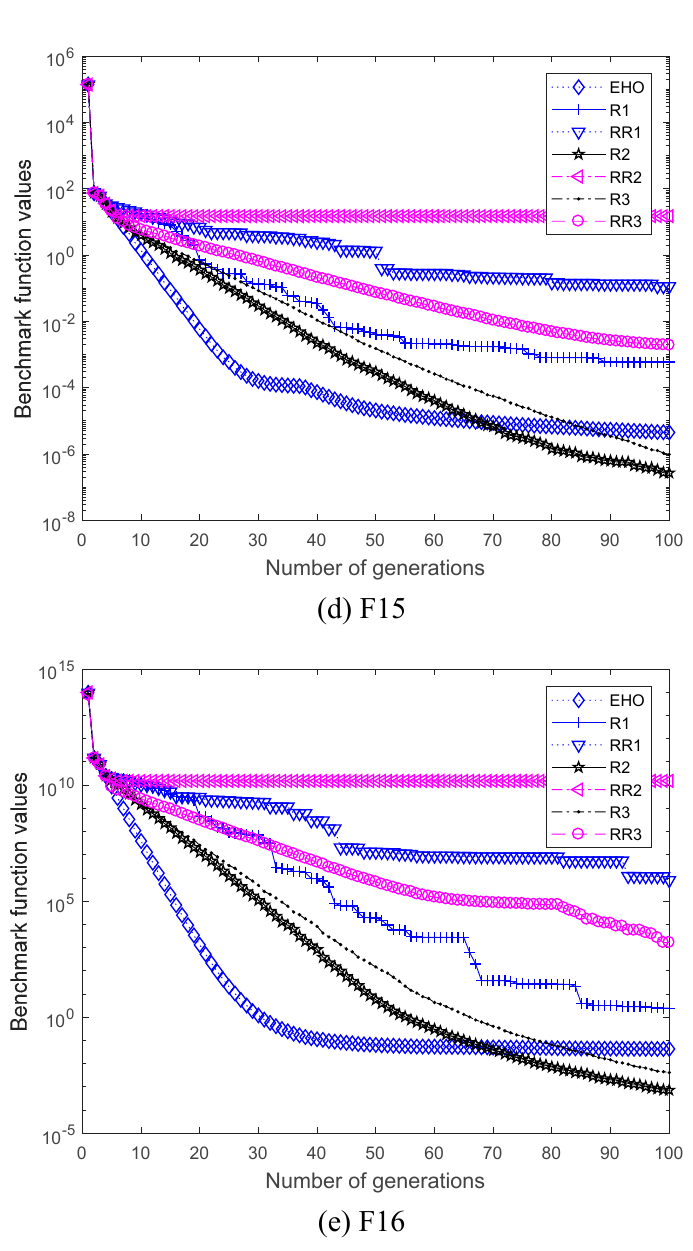
Figure 2. Optimization process of seven algorithms on five functions with D = 100.